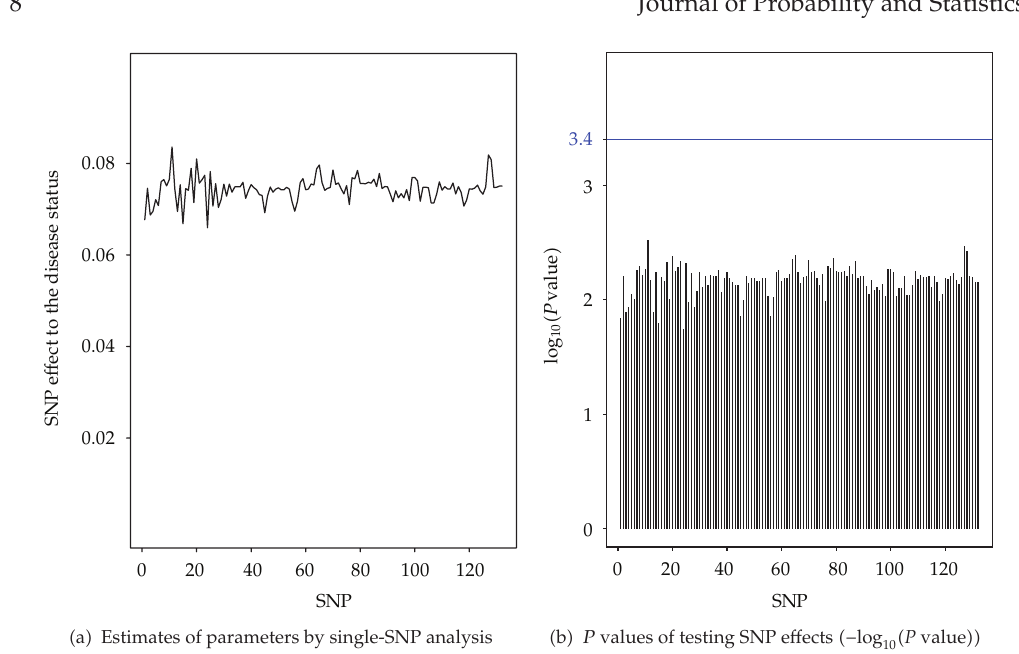
Figure 3: Analysis of genes for IGT/IFG through IGT pathway (cid:2) Data Set D1 (cid:3) with single-SNP analysis.